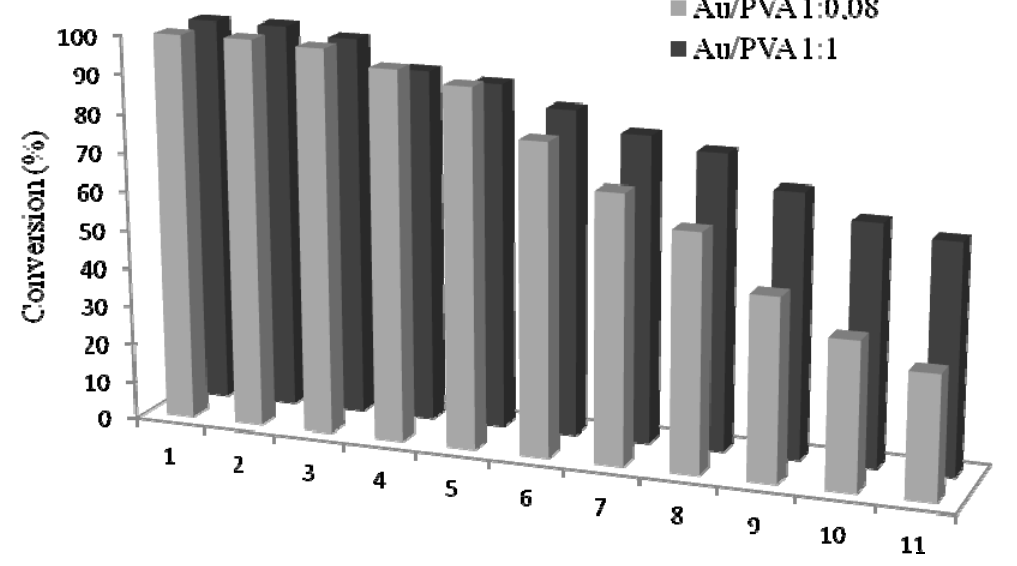
Figure 7. Stability of Au/AC by varying the Au/protective agent (PVA) weight